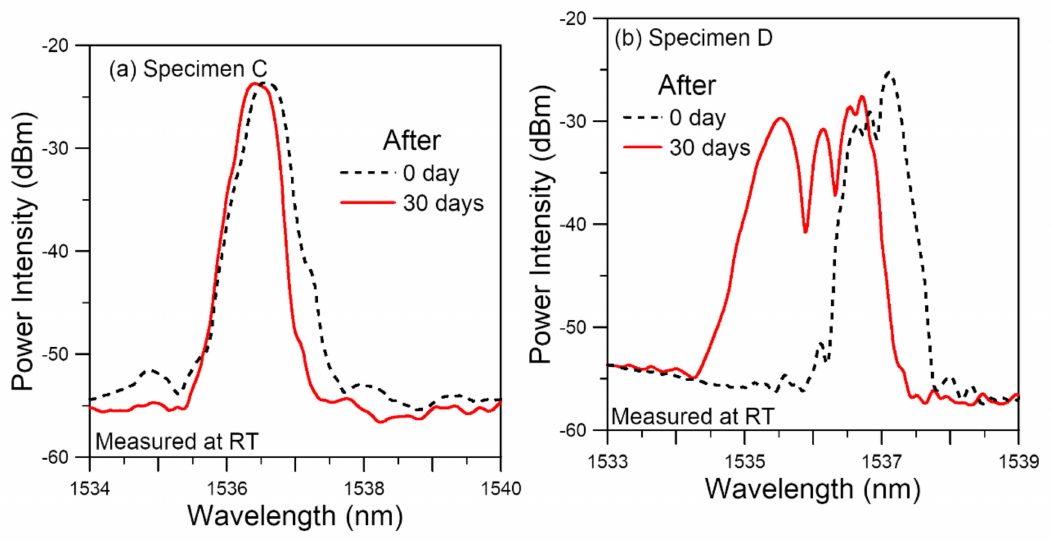
Figure 13. Comparison of room temperature FBG spectra before and after soaking at 60 ◦ C for 30 days from Specimens ( a ) C, which shows a slight spectrum narrowing; ( b ) D, which shows a marked broadening and peak